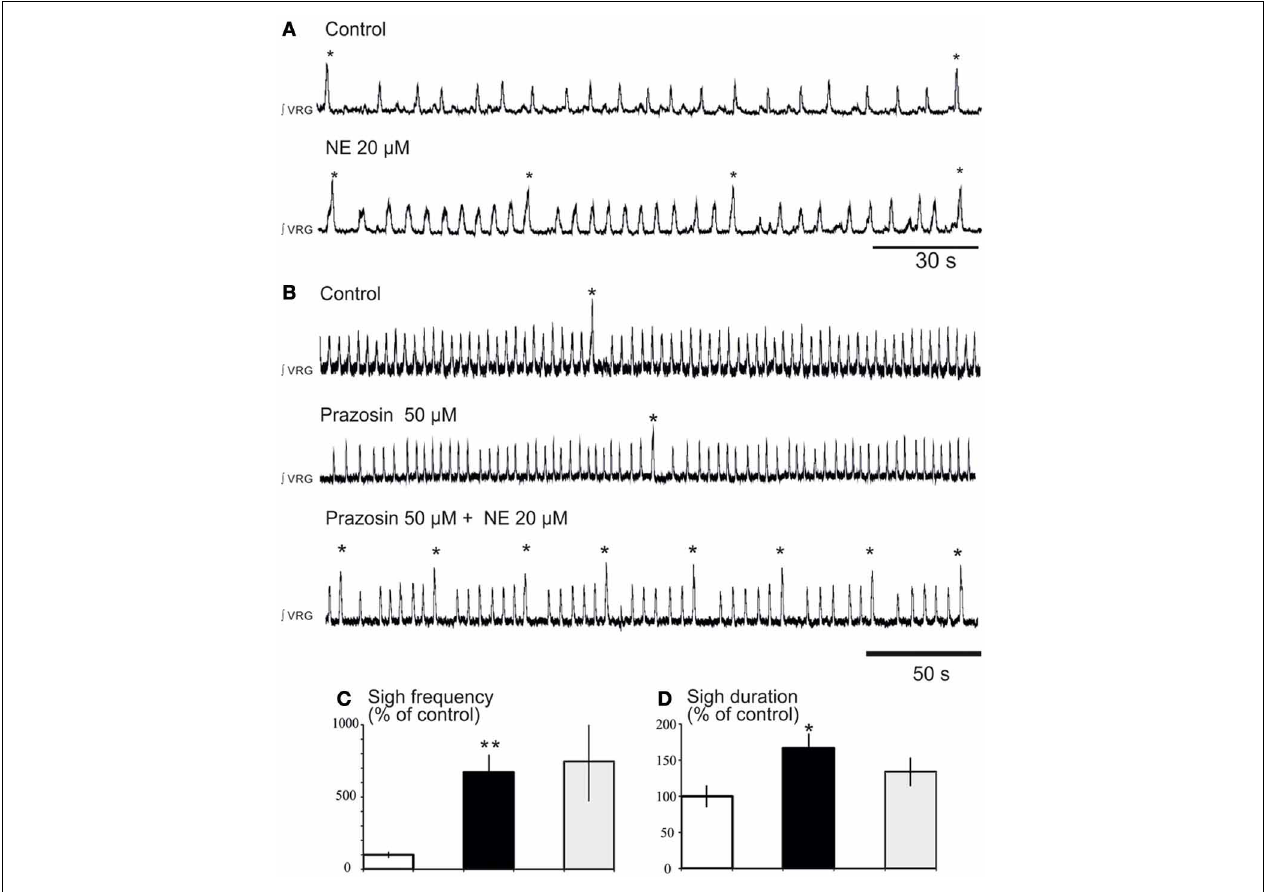
FIGURE 3 | Blockade of α 1-NR does not abolish the noradrenergic modulation of fictive sigh activity. (A) Application of NE 20 μ M increases the frequency of “fictive eupneic” respiratory activity as well as the sigh activity compared to control. (B) Blockade of α 1-NR(prazosin 50 μ M)